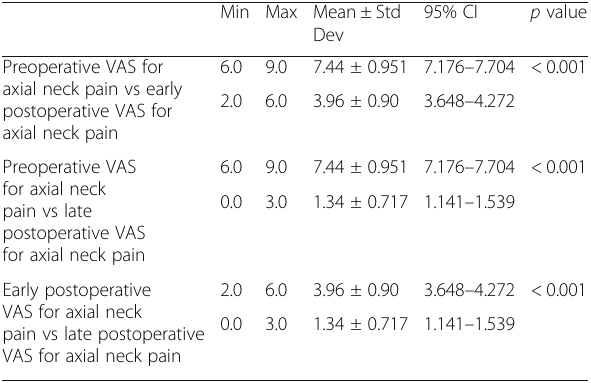
Table 3 Comparison between preoperative and early postoperative values of radicular motor power Preoperative radicular motor power